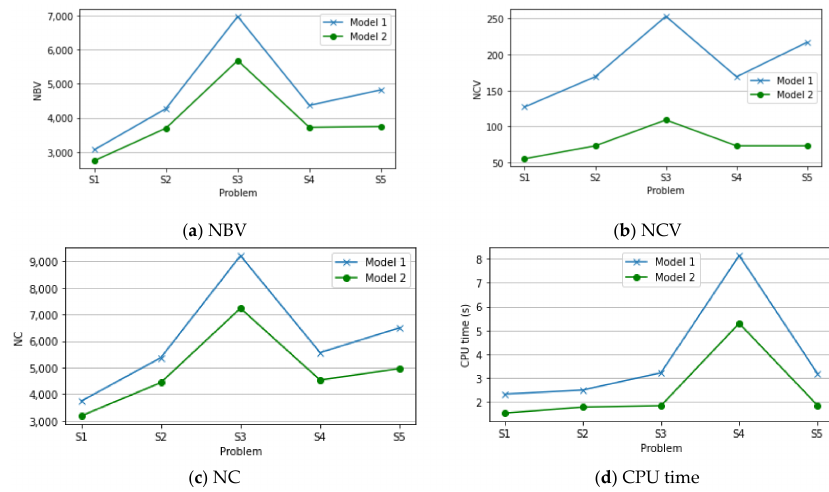
Figure 3. Comparison of model sizes, as the ( a ) NBV (number of binary variables), ( b ) NCV (number of continuous variables), and ( c ) NC (number of constraints) and ( d ) the CPU times for solving the small problems between Model 1 and Model 2. Table 11. Computational results of the medium problems using Model 1 and Model 2.